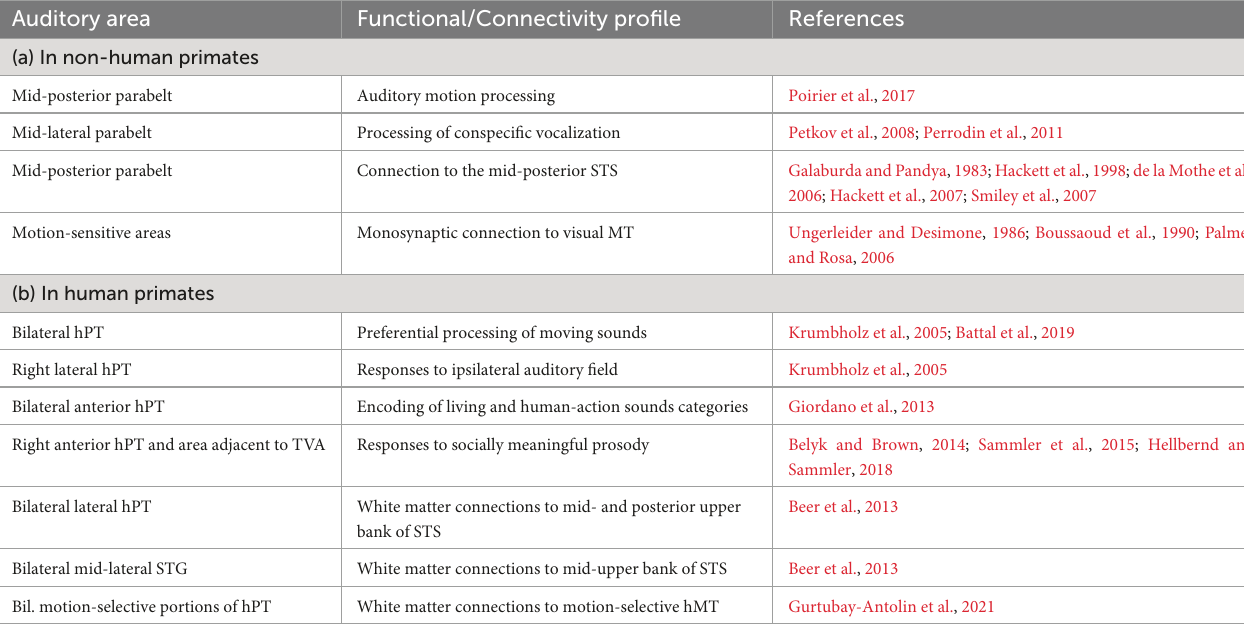
TABLE 1 Functional properties and structural connectivity profile of mid-posterior and lateral auditory areas in the superior temporal gyrus as described in (a) non-human and (b) human